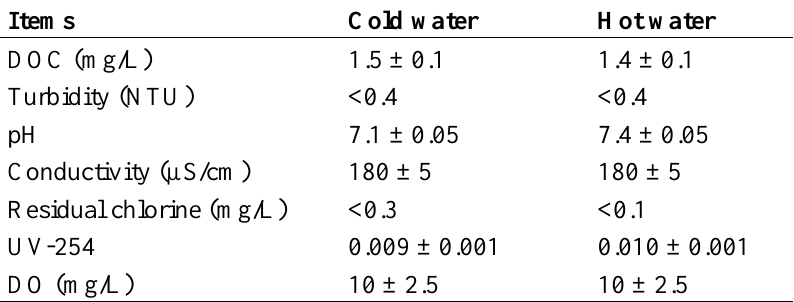
Table 1. Tap water quality used in this